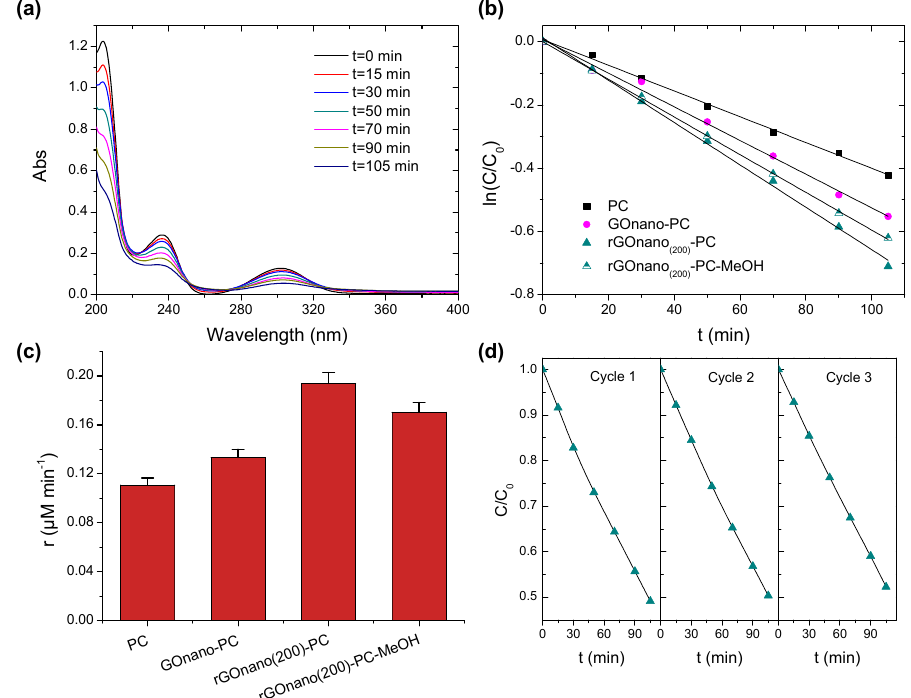
Figure 7. ( a ) Salicylic acid (SA) absorbance variation for the rGOnano(200)-PC film under UV–VIS light. Photodegradation ( b ) kinetics and ( c ) reaction rates of SA for the PC, GOnano-PC and rGOnano(200)-PC inverse opals under UV-VIS irradiation. ( d ) SA photodegradation kinetics after three successive photocatalytic tests using the rGOnano(200)-PC film.